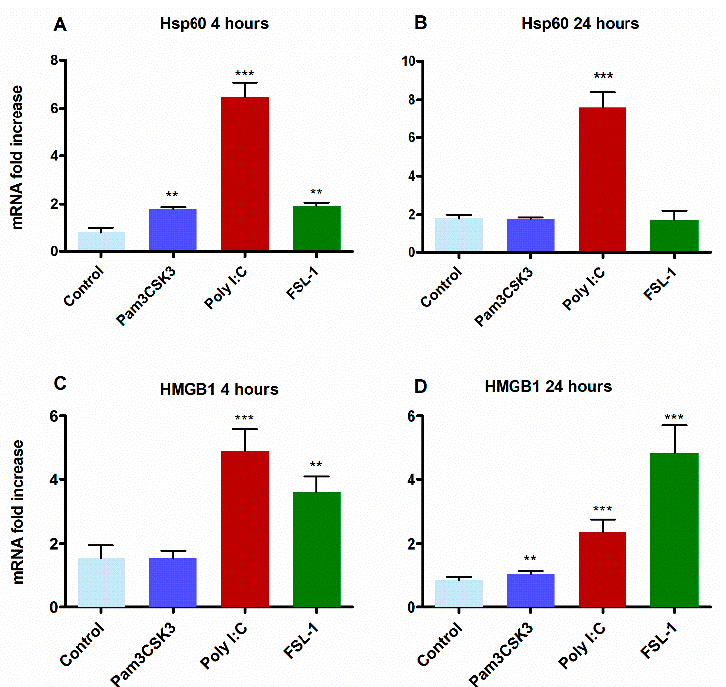
Figure 7. TLR3 stimulation activated endogenous TLR2 ligands: the HGECs were stimulated with Pam3CSK3, poly I:C and FSL-1 for 4 and 24 h. The cDNA was used to measure HMGB1 and Hsp60 gene expression. Poly I:C increased the expression of both the Hsp60 (HSPD1) and HMGB1 genes. Poly I:C increased the significantly higher HMGB1 expression at the 4 h time point ( A ), whereas FSL1 induced higher the HMGB1 at 24 h ( B ). On the other hand, Hsp60 expression was minimally activated by FSL-1 treatment but robustly upregulated by poly I:C at the 4 and 24 h time points ( C , D ). Statistical test: one-way ANOVA followed by Tukey’s multiple comparison test (* p < 0.05, ** p < 0.01, *** p < 0.001) and the results are represented as the mean ± SE ( n = 3) from three independent experiments. Cells 2020 , 9 , x FOR PEER REVIEW Then, the TNF and IL-8 levels were measured to check the functionality of HMGB1 and HSP60 when they were silenced. When we treated poly I:C in Hsp60 and HMGB1-silenced HGECs, the TNF with cells treated with poly I:C and siRNA mock. This shows the role of HMGB1 and HSP60 in the functional activation of TLR2 in inducting TNF and IL-8 expression (Figure 8A,B).